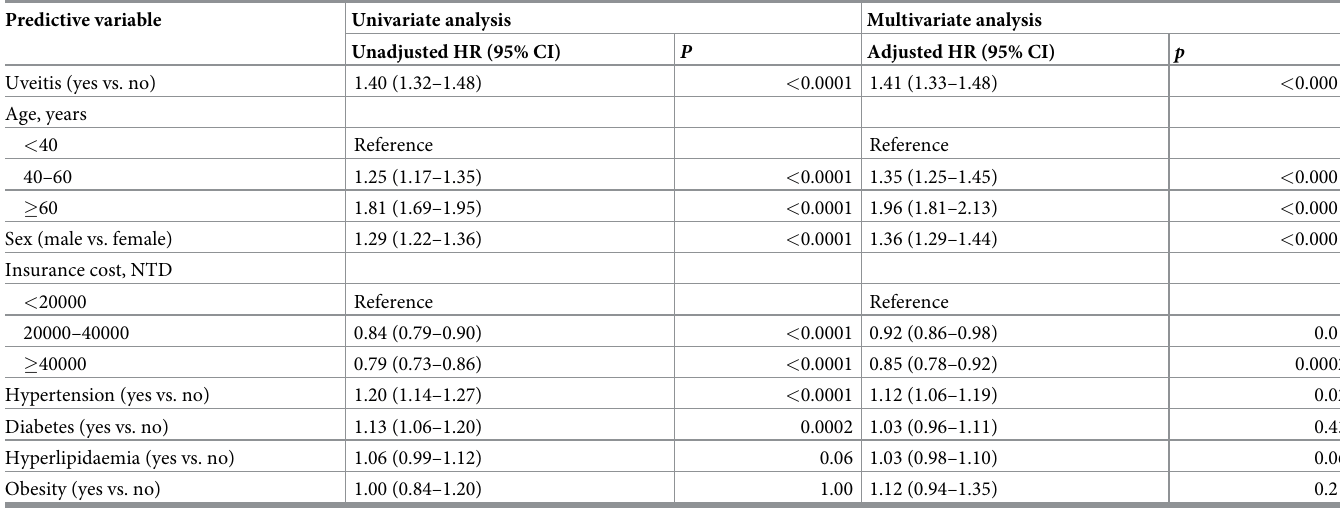
Table 2. Risk factors for PS and PSA in patients with and without uveitis. Predictive